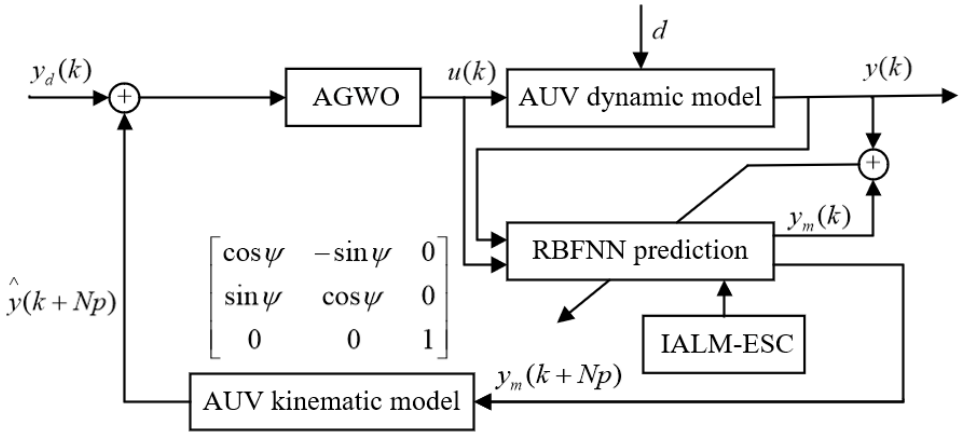
Figure 2. Control schematic diagram of the proposed RBF-NMPC.